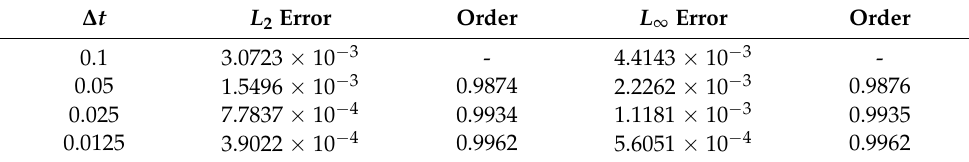
Figure 2. Comparisons between the analytical solutions and numerical solutions of t . Table 1. The truncation error and convergence order of velocity u with ∆ y = 0.01.